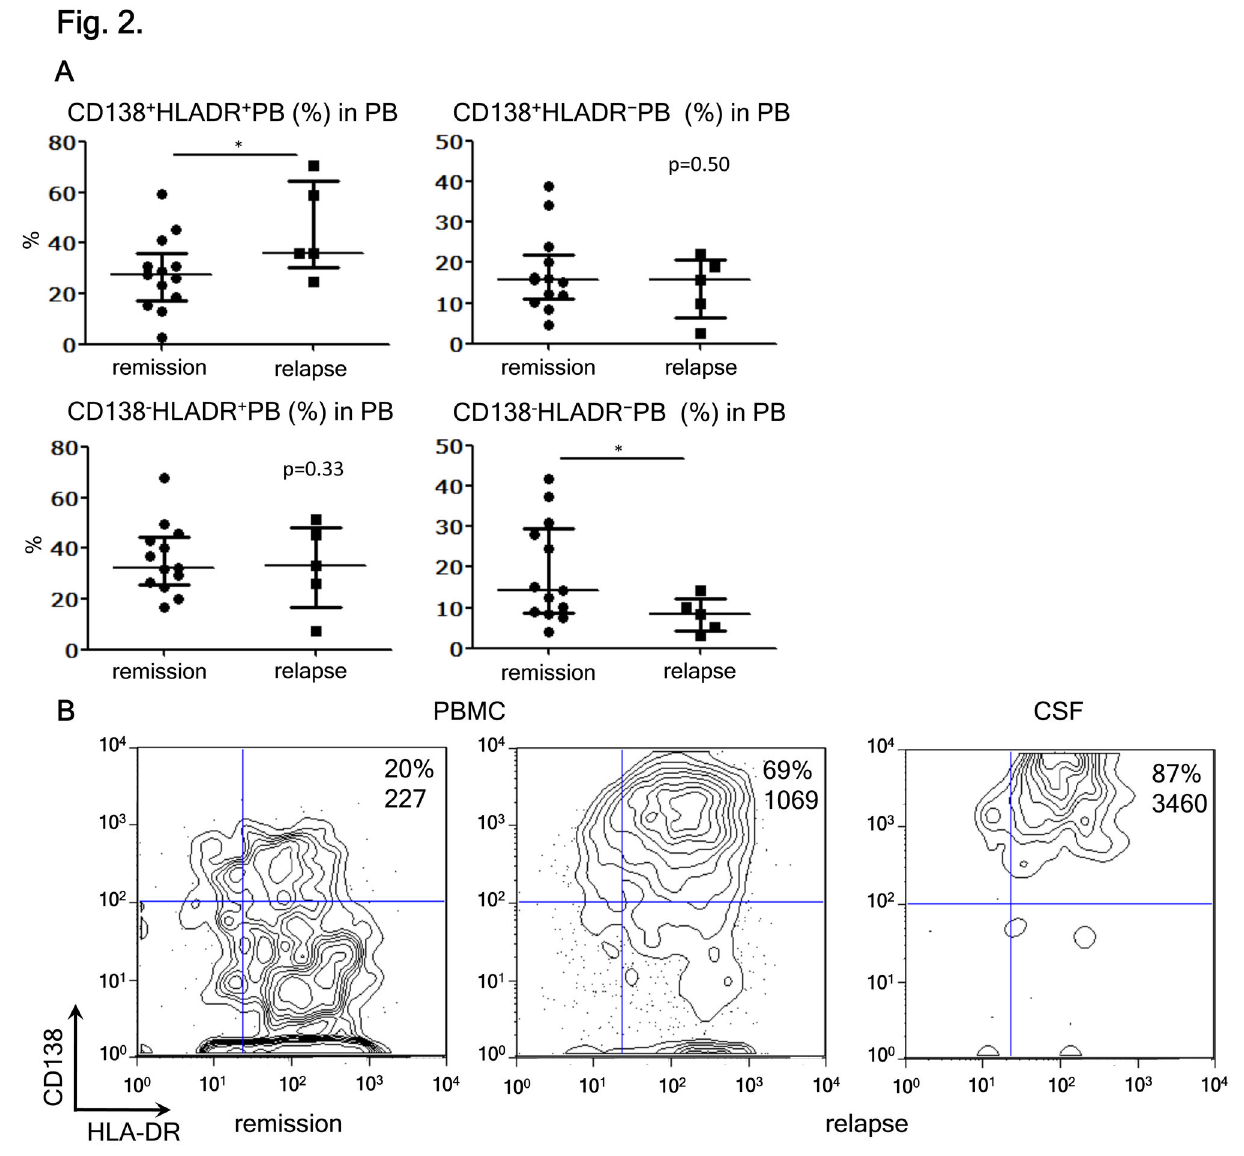
Figure 2. Kinetics of CD138 + HLA-DR + PB during relapse of NMO. (A) Analysis of pooled peripheral blood mononuclear cells (PBMC) data from neuromyelitis optica (NMO) in remission and relapse. The plasmablasts (PBs) were subdivided into four subpopulations by considering the expression of CD138 and HLA-DR. The individual data show the percentages of each PB subpopulation among the total PB [*p < 0.05 by Mann–Whitney test; each error bar represents the median ± interquartile range (IQR)]. (B) Enrichment of CD138 + HLA-DR + PBs in the CSF. The PBMC and CSF cells were obtained from NMO during relapse. The values indicate the percentages of CD138 + HLA-DR + PBs among the total PB. The expression level of CD138 was assessed by mean fluorescence intensity (MFI). Representative data of one out of three different cases are shown. doi: